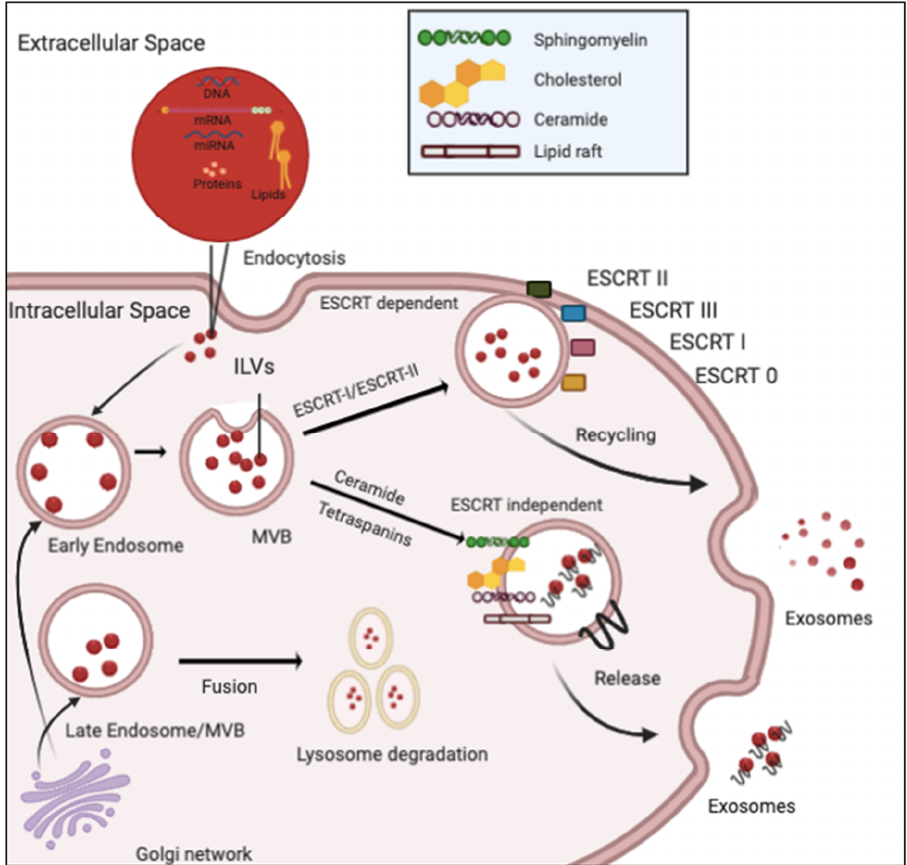
Figure 1. Biogenesis of exosomes: This process initiates with endocytosis. Subsequently, endocytic vesicles get formed and delivered to early endosomes which later fuse with each other forming late endosomes/multivesicular bodies (MVBs). MVBs release exosomes either by fusing with the cell membrane or subject their content to lysosomal degradation. The Trans-Golgi network (TGN) and Endosomal Sorting Complex Responsible for Transport (ESCRT) are also involved in exosome biogenesis and secretion into the extracellular space.